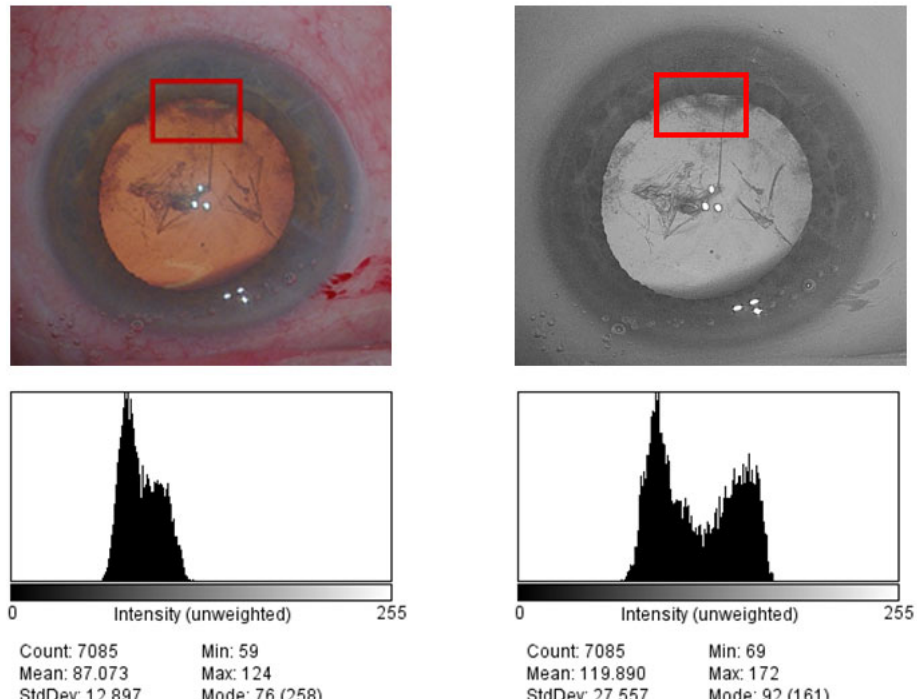
Figure 1. Standard color and BW filter images obtained during capsulorhexis and their luminance histograms in pixel values using image J software. The contrast of the region of interest which represents the difference in the standard deviation (DSD) of pixel intensity values was 12,897 for standard colors and 27,557 for BW filter.